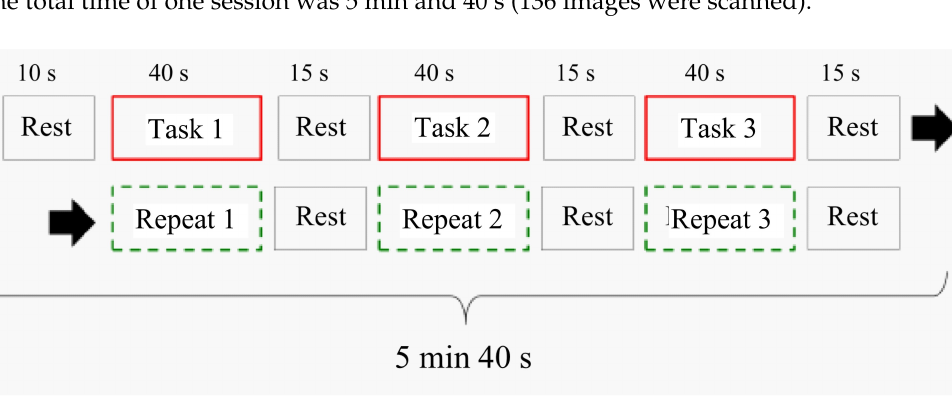
Figure 4. Task sequence during one